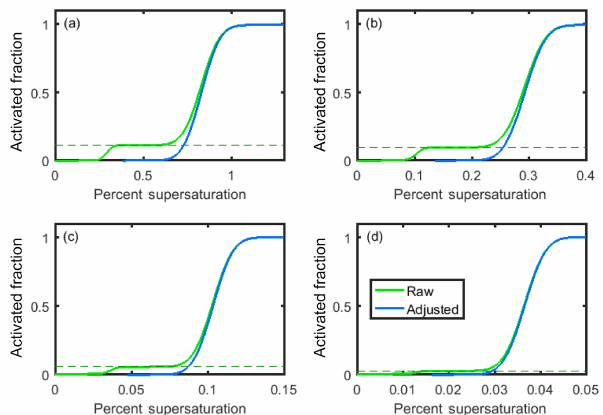
Figure 5. Theoretical raw (green) and adjusted (blue) activated frac- tion curves for (a) 25nm ( + 1), 50nm ( + 2), and 75nm ( + 3) par- ticles; (b) 50nm ( + 1), 100nm ( + 2), and 150nm ( + 3) particles; (c) 100nm ( + 1), 200nm ( + 2), and 300nm ( + 3) particles; and (d) 200nm ( + 1), 400nm ( + 2), and 600nm ( + 3) particles. All par- ticles are pure sodium